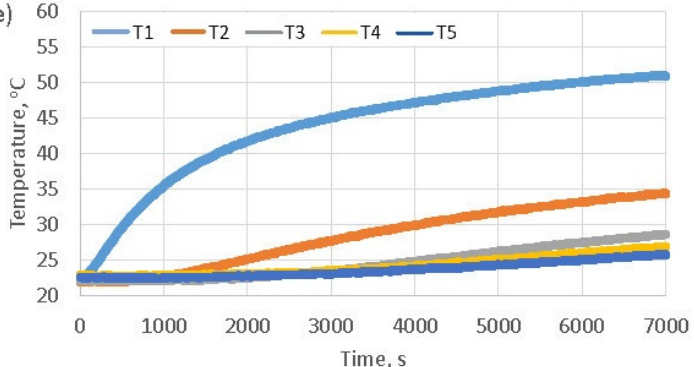
Figure 9. Diagrams of temperature dependence for individual thermocouples T1( t ), T2( t ), T3( t ), T4( t ), T5( t ) on the heating time of the concrete samples varying bulk density: ( a ) 2319 kg ( c ) 773 kg , ( d ) 636 kg , ( e ) 434 kg . m 3 m 3 m 3